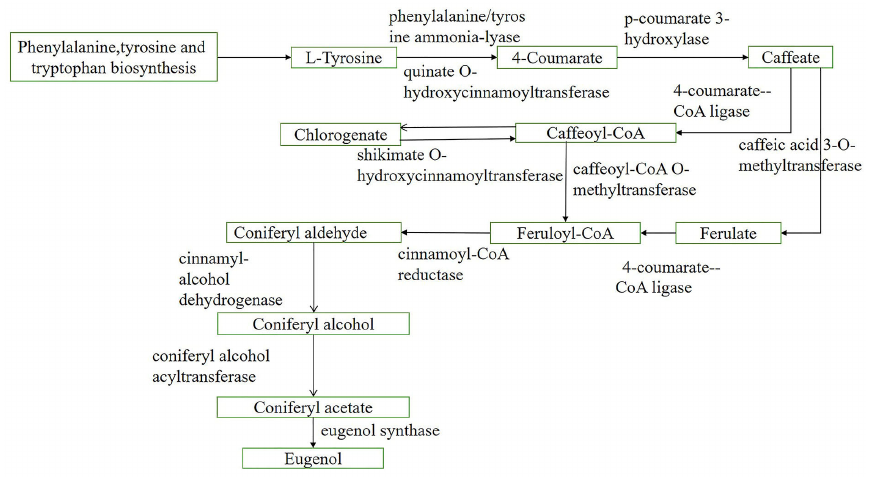
Figure 4. Chlorogenic and eugenol synthetic related pathway in phenylpropanoid biosynthesis